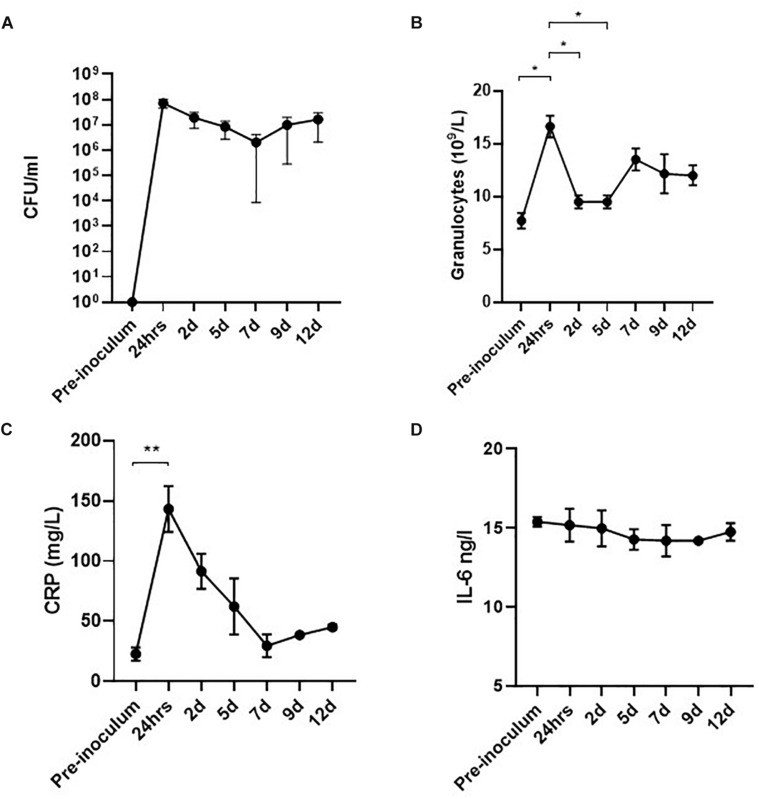
Level of bacteriuria and inflammatory biomarkers during infection of pigs (n = 4). The infected pig bladders remain significantly colonized throughout the experiment (A). Within the first 24 h of infection, granulocytes are rapidly rising reaching maximum concentrations of 14.9 × 109/ml. Shortly after, a small drop in granulocyte level is observed though remaining elevated until termination of the experiment (B). CRP increases > 7-fold at 24 hpi (peak-value) and decrease linearly hereafter, reaching baseline values at 7 dpi (C). No observable change in levels of IL-6 was seen during infection (D). Graphs represent means ± standard error of the mean. ∗P < 0.05, ∗∗P < 0.001, one-way ANOVA with Tukey’s multiple comparisons test. Data from 7 days onward are based on two pigs only. CFU, colony forming units; IL-6, interleukin-6.